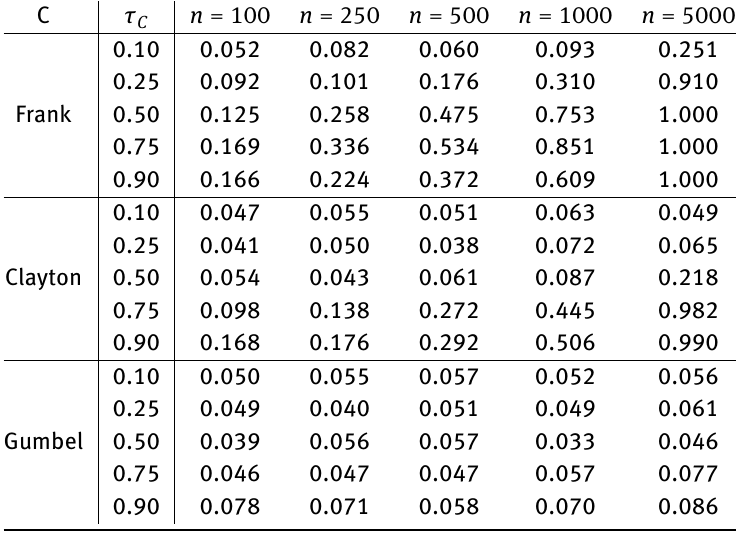
Table 12: d = 2 : Empirical power of the test for ellipticity with significance level α = 0.05 based on the test statistic T n : rate